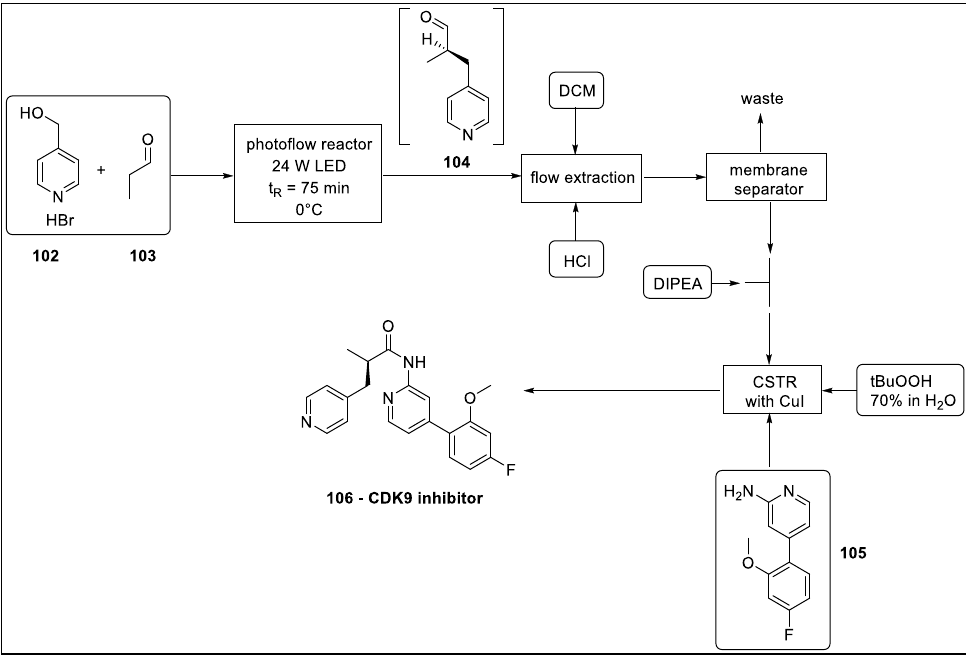
Table 2. Summary table of photochemical preparations of